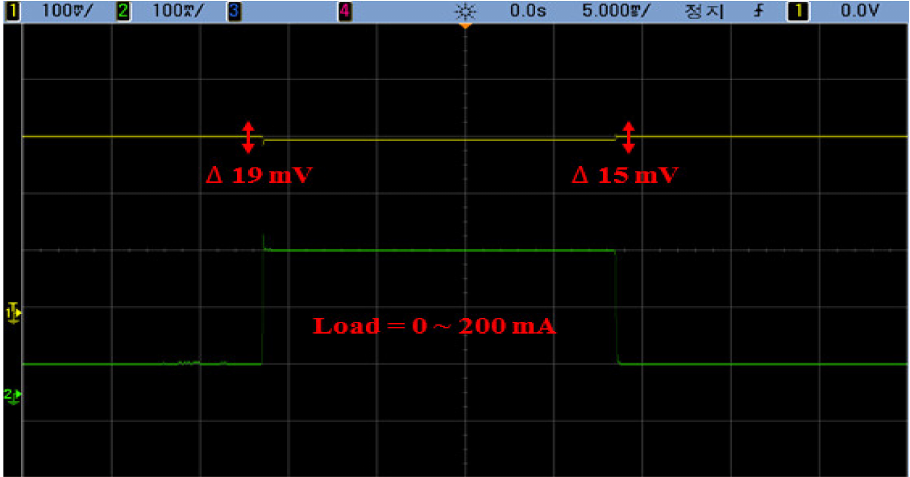
Figure 11. Load transient of the proposed LDO regulator (Load = 200